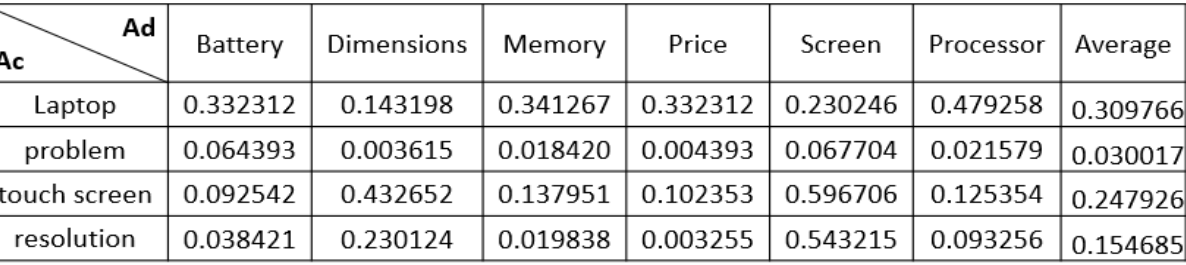
Figure 5. An example of semantic similarity. Ac: candidate aspects; Ad: direct aspects.